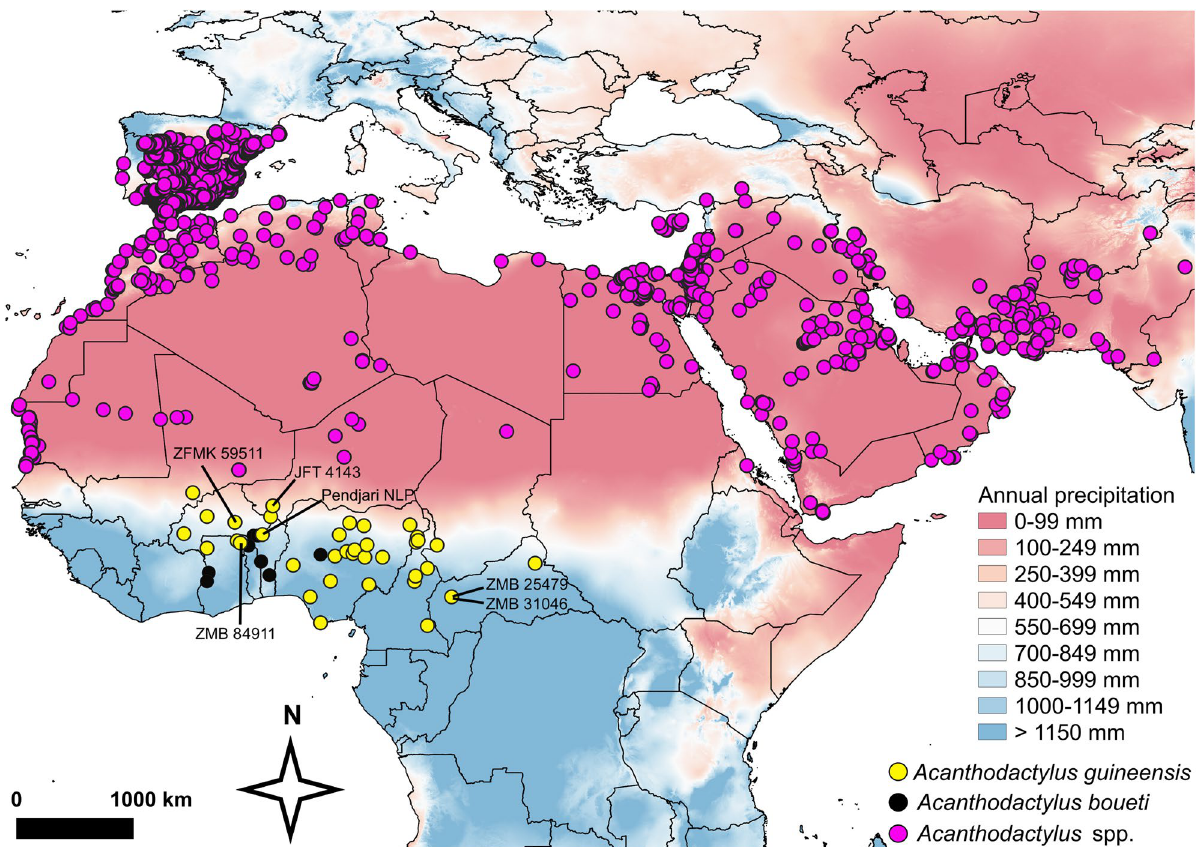
Figure 3. Updated distribution map for Acanthodactylus guineensis (yellow circle) and A. boueti (black circle) including all literature and GBIF records and our own discoveries from this study (unpublished). In addition, we present all records from the genus Acanthodactylus (purple circle) as downloaded from GBIF. The specimen that we sequenced (ZFMK 59511 43 ), museum specimens studied herein (holotype E. mandjarum ZMB 25479, ZMB 31046, ZMB 84911), the previously unpublished country record for Benin 38 , and the A. guineensis specimen collected by JFT (4143, GenBank record A275 14 ) that we added to our phylogeny are separately labeled on the map. In the background, data on mean annual precipitation in mm is shown, with cooler colors representing wetter conditions and warmer colors representing drier conditions. The figure was created using QGIS 3.14.16 (https:// www. qgis.